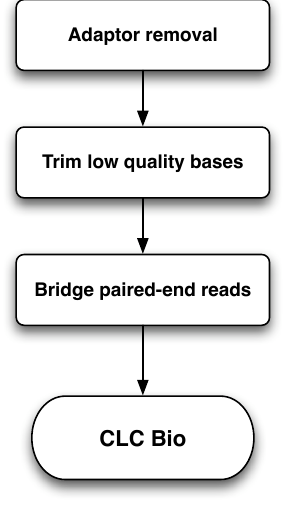
Figure 1: Genome assembly